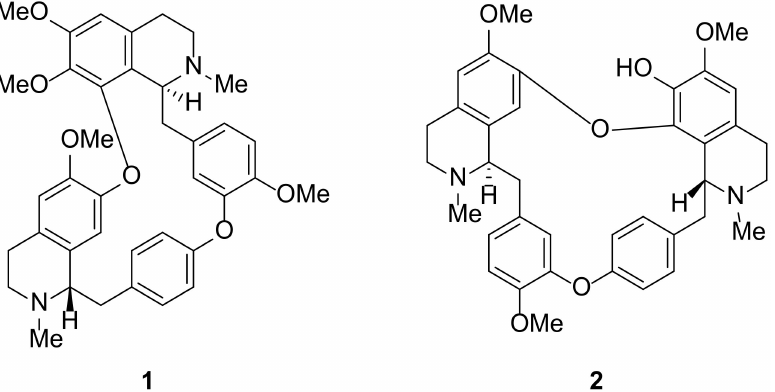
Figure 1. Tetrahydrobisbenzylisoquinoline alkaloids tetrandrine ( 1 ) and limacusine ( 2 ) from Phaean- thus ophthalmicus